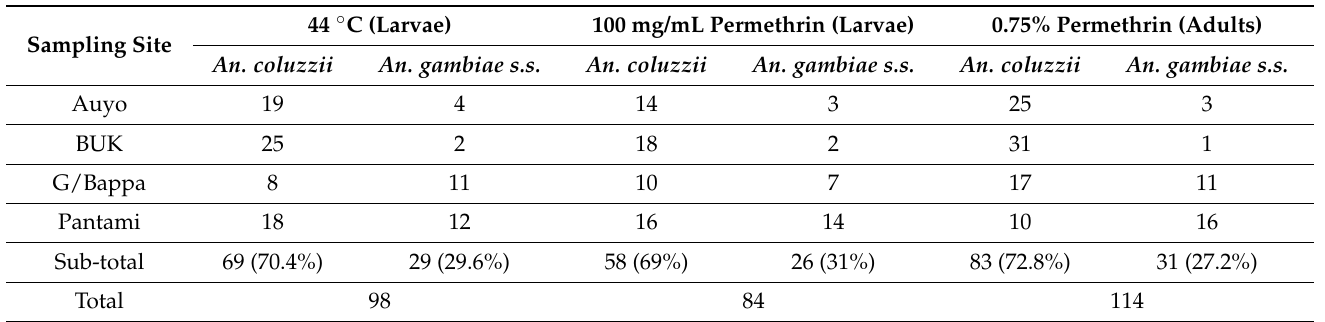
Table 1. Distribution and composition of An. gambiae s.l.